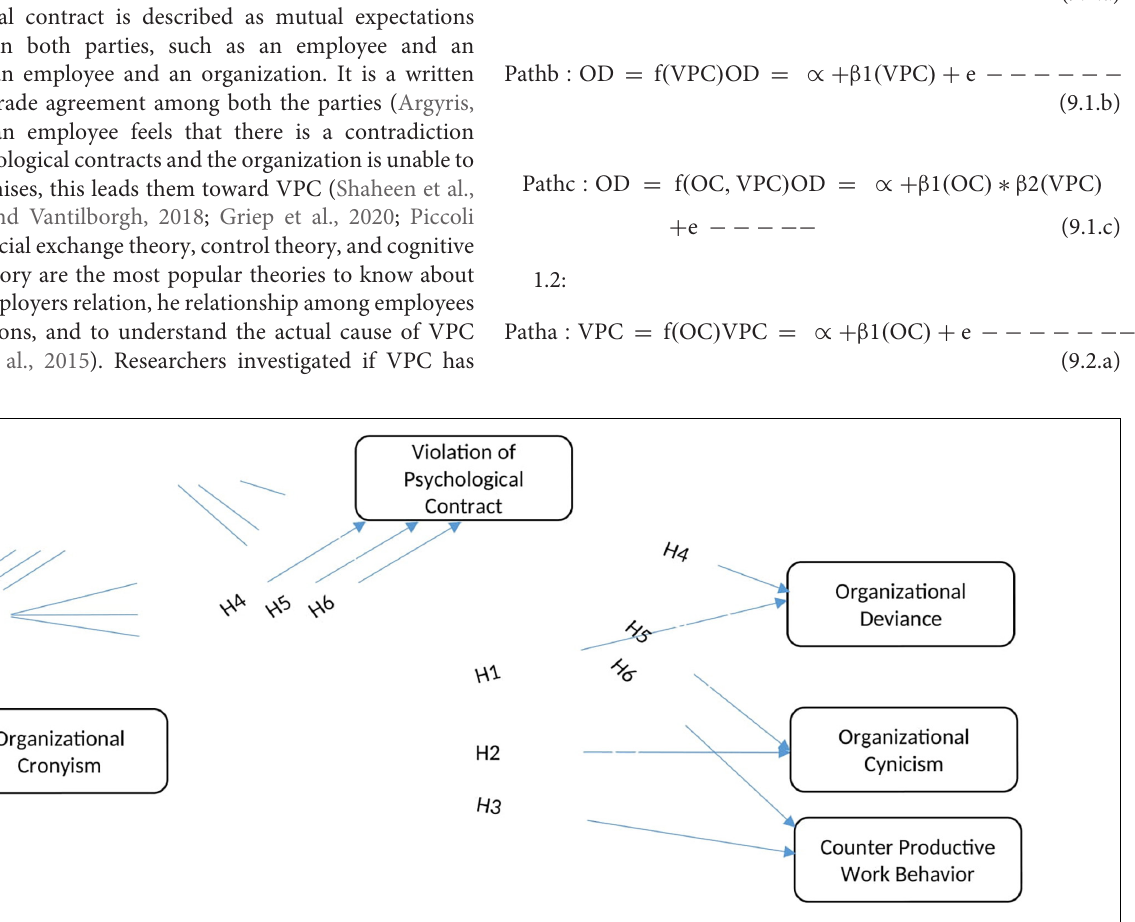
FIGURE 1 | Research